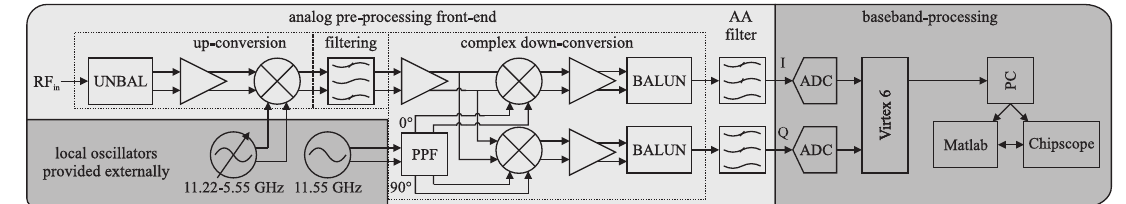
Figure 1. Frontend connected to the base-band processing.